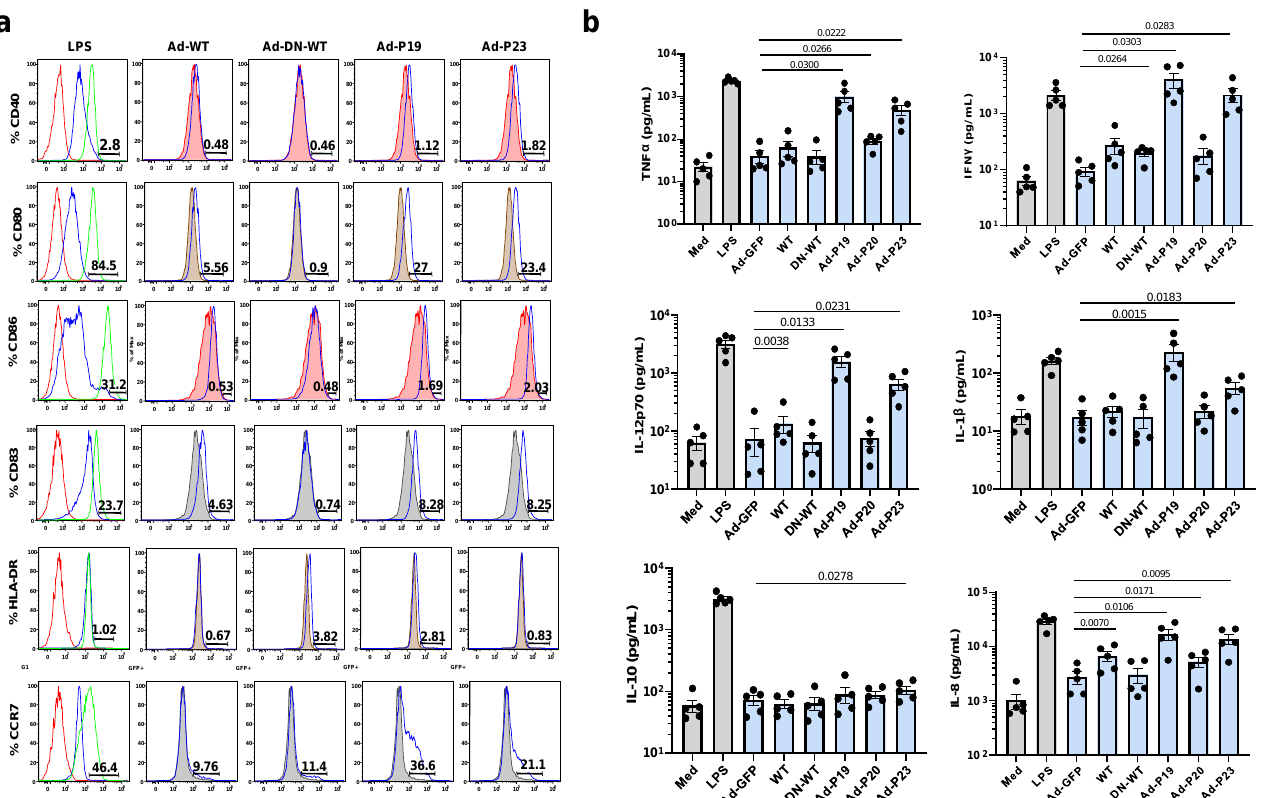
GFP+ Figure 2. Phenotypic characterization of dendritic cells (DC)differentiation and cytokine profile after transduction with DAP12 mutants. ( a ) Flow cytometric analysis of five-day Mo-DCs were treated with Ad-GFP, Ad-WT, Ad-DN-WT, Ad-P19, Ad-P23, or LPS (2 µ g/mL) for 48 h for changes in CD40, CD80, CD86, CD83, HLA-DR and CCR7. Each experimental construct was compared to the empty-vector control, filled histograms, and infected cells were gated on GFP prior to analysis. In LPS histograms, red denotes unstained cells, blue isotype and green is stain as labeled. In subsequent histograms filled histograms are isotype and open are marker of interest as labeled. ( b ) Supernatants from experiment “a” were analyzed by TNF- α , IFN- γ , IL-8, IL-1 β , IL-12p70, or IL-10 specific ELISA. Results are expressed as mean value ± SEM of 5 independent experiments. Significance was assessed by comparing against Ad-GFP transfected cells via paired student t test (shown) or ANOVA in Supplemental Table S2. Analyzed data is shown in light blue and medium (MED) and LPS serve as other negative and positive controls respectively (shown in